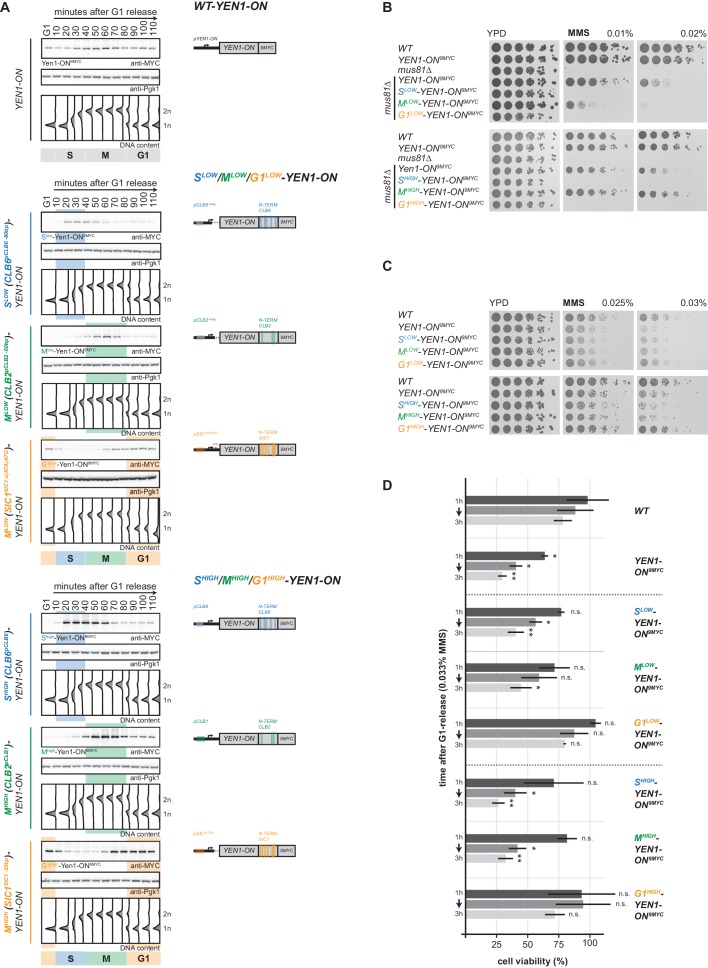
Premature activation of Yen1 in S or early M phase interferes with the response to replication stalling lesions.(A) Cell cycle-tagged Yen1-ON-9MYC constructs restrict expression of constitutively active Yen1-ON to S, M or G1 phase. (Left) Western blot analysis of strains expressing WT, S (Slow (Clb6pClb6 -80bp)-Yen1-ON9MYC/Shigh (Clb6pClb6)-Yen1-ON9MYC), M (Mlow (Clb2pClb2 -60bp)-Yen1-ON9MYC/Mhigh (Clb2pClb1)-Yen1-ON9MYC) and G1 (G1low (Sic1pSic1 u(ATA)ATG)-Yen1-ON9MYC/G1high (Sic1pSic1 -20bp)-Yen1-ON9MYC) phase-restricted Yen1-ON during synchronous cell cycle progression as in Figure 2A. (see Figure 5—figure supplement 2 for quantification of peak expression levels for individual constructs). (Right) schematic representation of endogenously expressed and cell cycle-tagged Yen1-ON constructs. Blue, green and orange bars indicate location of cell cycle regulatory elements in the promoter and N-terminal degron sequence. (B), The M phase function of Yen1-ON is able to bypass Mus81 requirement after MMS induced replication fork stalling. Strains with indicated genotypes were chronically exposed to MMS as in Figure 3A (note the mus81Δ background). (C–D), Viability after MMS induced replication fork stalling decreases when Yen1-ON is restricted to S or early M phase. (C) Survival of indicated strains after chronic MMS exposure as in (B). (D) Viability assay after a single pulse of MMS in S phase was measured for indicated strains as in Figure 4A (see Figure 5—source data 1 for underlying values and exact p-values).
Figure 5—source data 1.average, stdv and p-values of normalized colony numbers from replicates 1–3 depicted in Figure 5D.